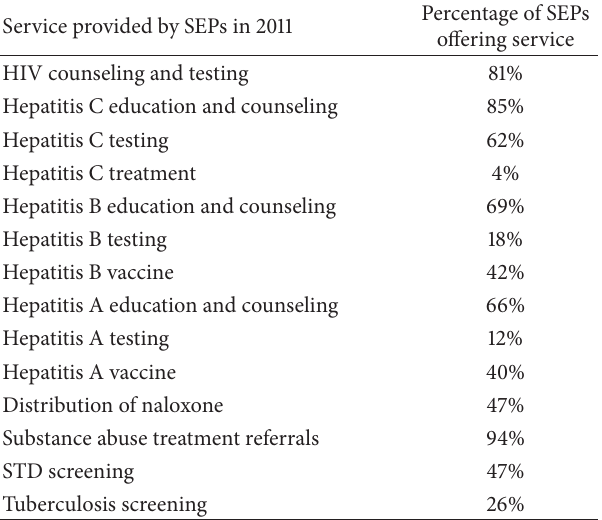
Table 1: Services provided at United States Syringe Exchange Programs,